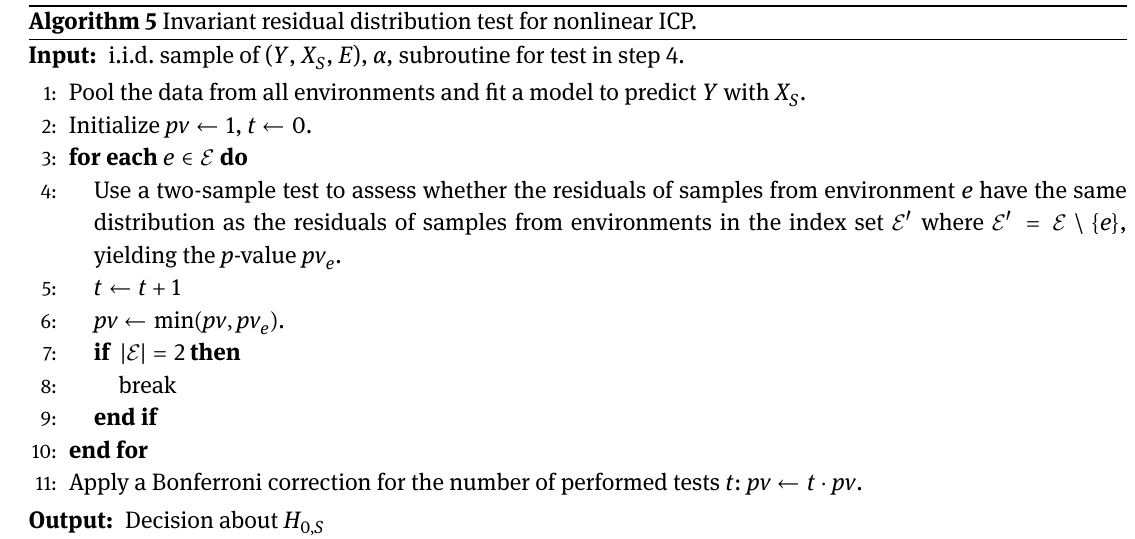
Algorithm 5 Invariant residual distribution test for nonlinear